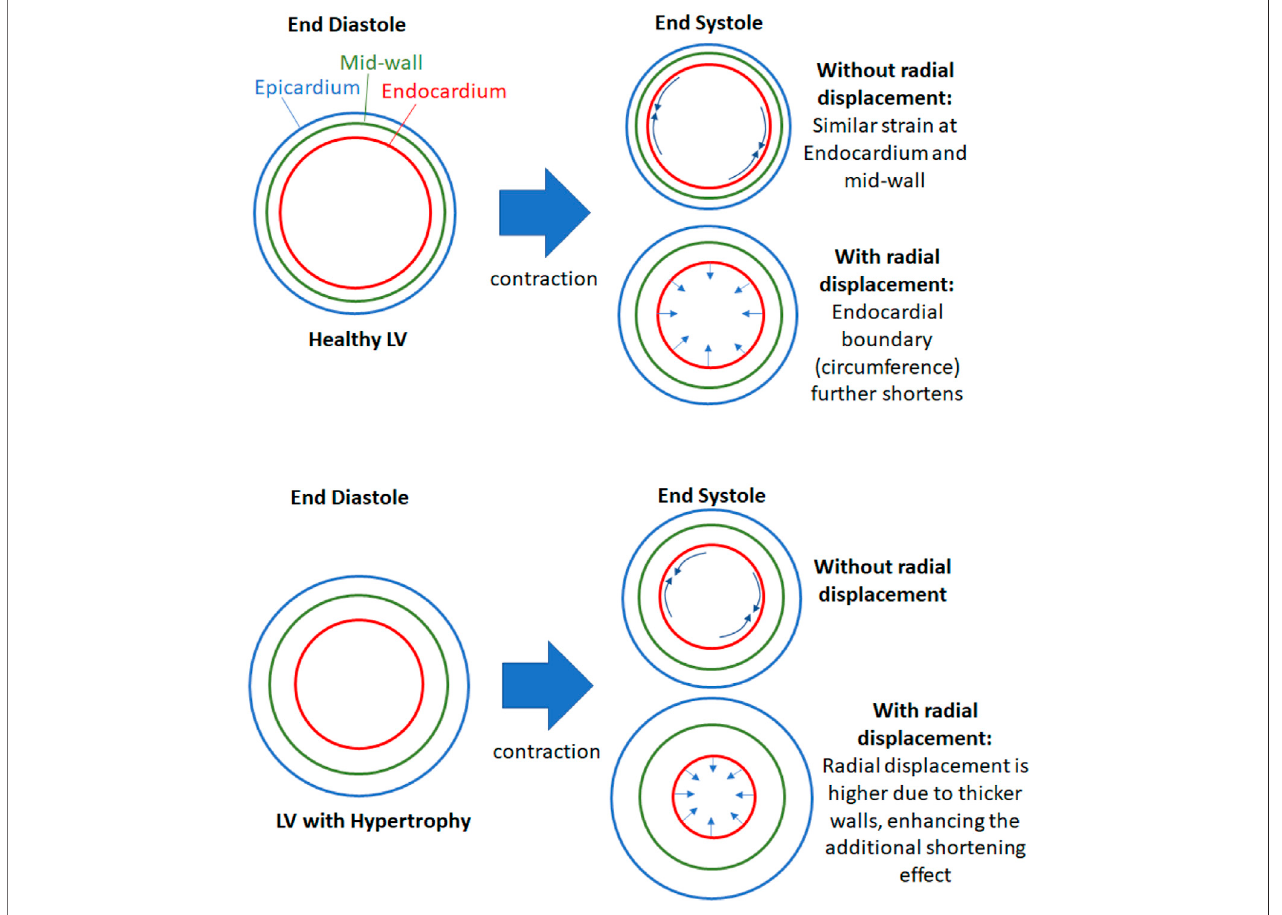
FIGURE 6 | Schematic to explain the effects of radial displacement on endocardial strains. During contractions, the endocardial boundary not only shortens circumferentially (and longitudinally) but it is also pushed inwards by radial displacement, which shortens the endocardial boundary further. This additional shortening effect is enhanced when the heart is hypertrophic and the wall is thicker, since thicker wall will have higher radial displacement if the radial strain is not changed.